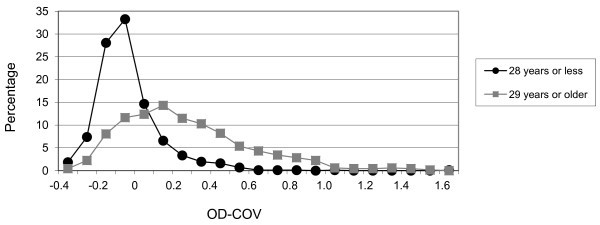
Distribution of IgG OD-COVs of persons born before (29 years or older, n = 670) and after (28 years or younger, n = 866) the eradication of smallpox in Sierra Leone. Values on the y-axis represent the percentage of persons in the age group with IgG OD-COVs falling within the plotted range.